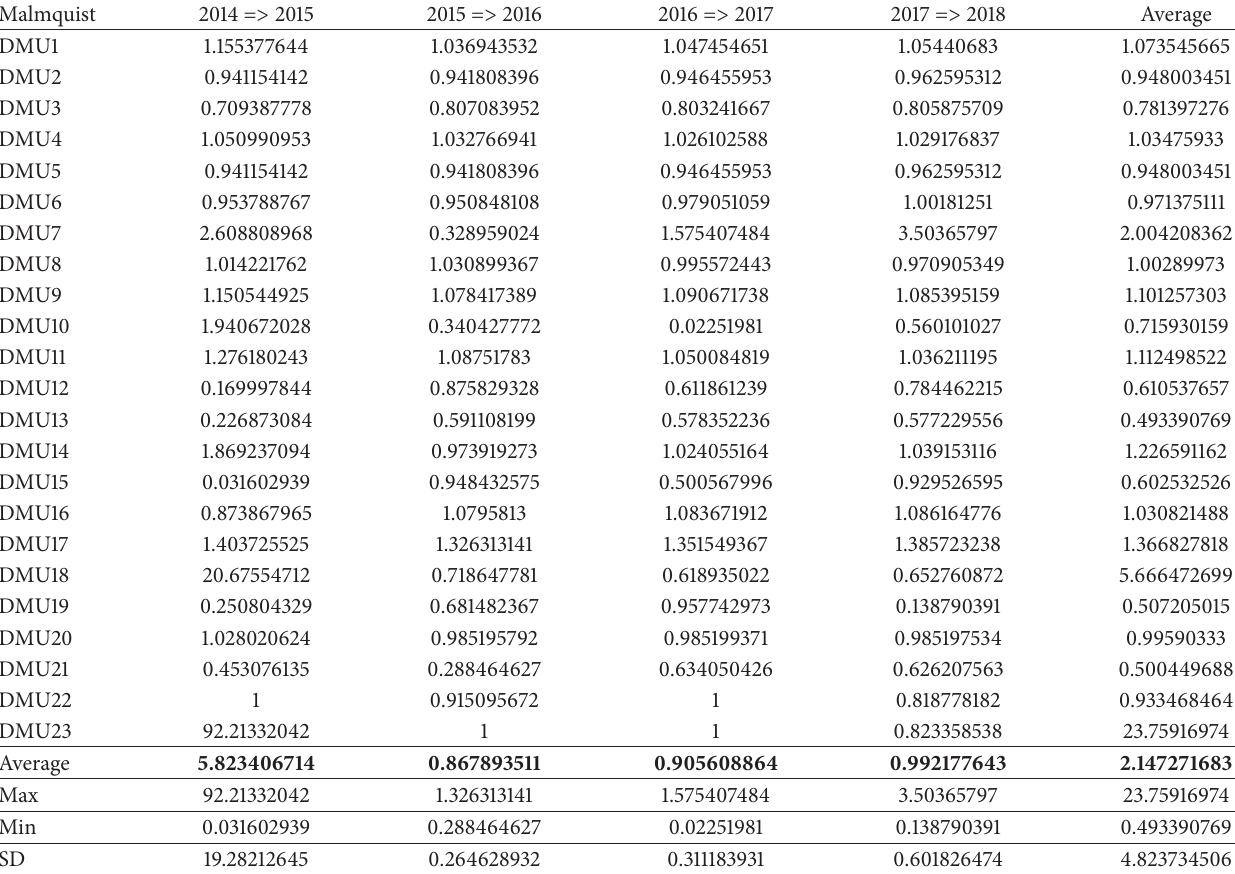
Table 16: MPI change over the forecasted period 2014 to